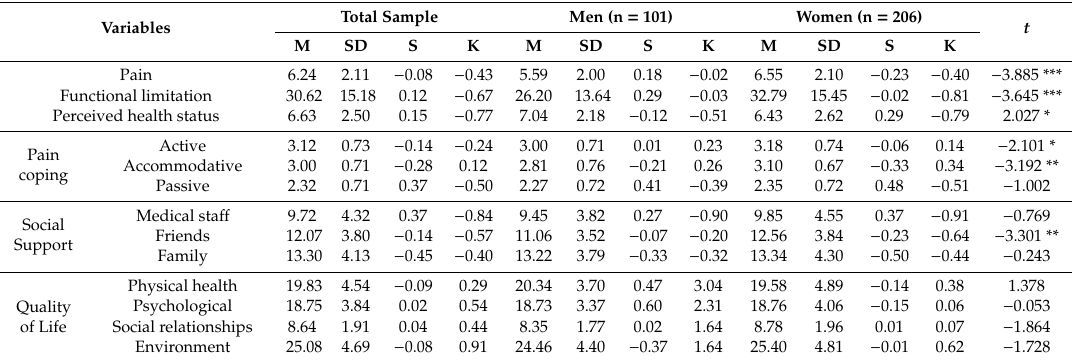
Table 1. Descriptive statistics and sex di ff erences of the major variables ( N = 307).